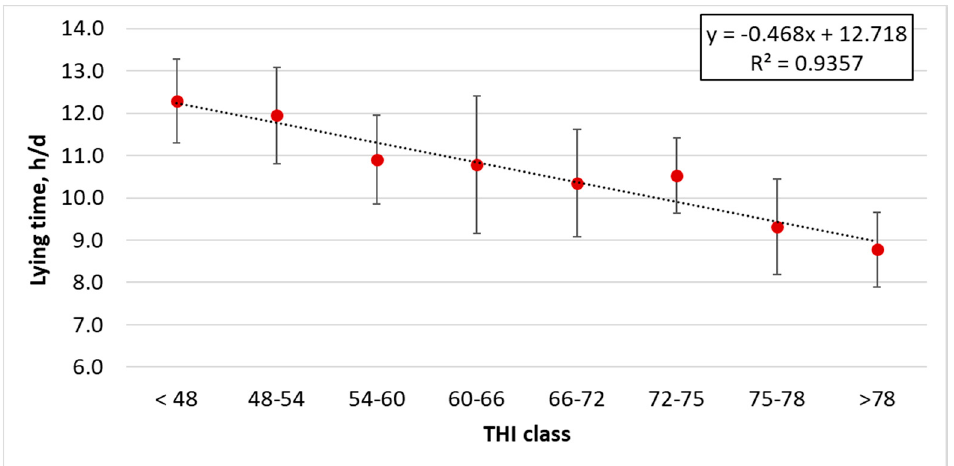
Figure 7. Relation between the lying behavior (lying time; h/d) of the dairy cows monitored at different classes of THI. Vertical bars express the standard deviations.